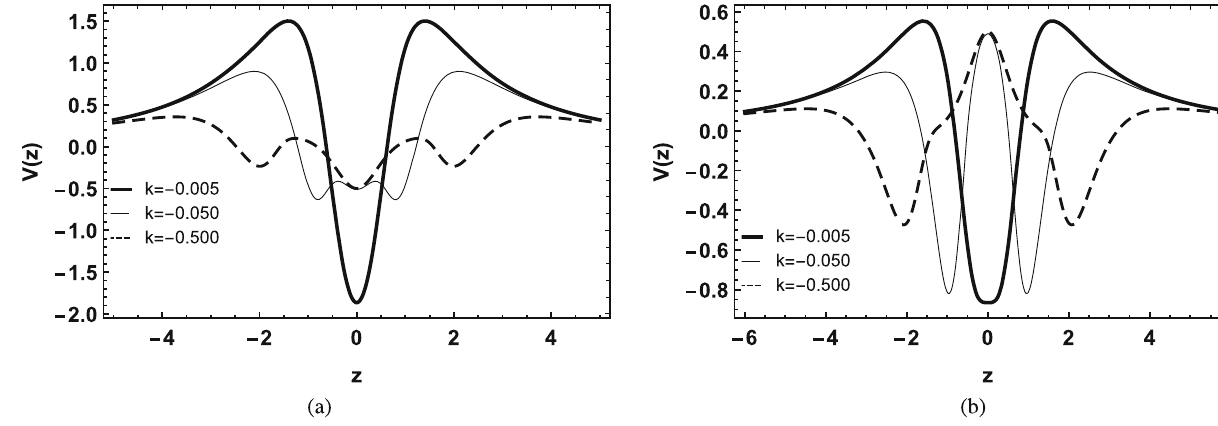
Fig. 12 Effective potential behavior for G 2 ( T ) with n = 2 and p = λ = 1. a Gauge field. b KR field